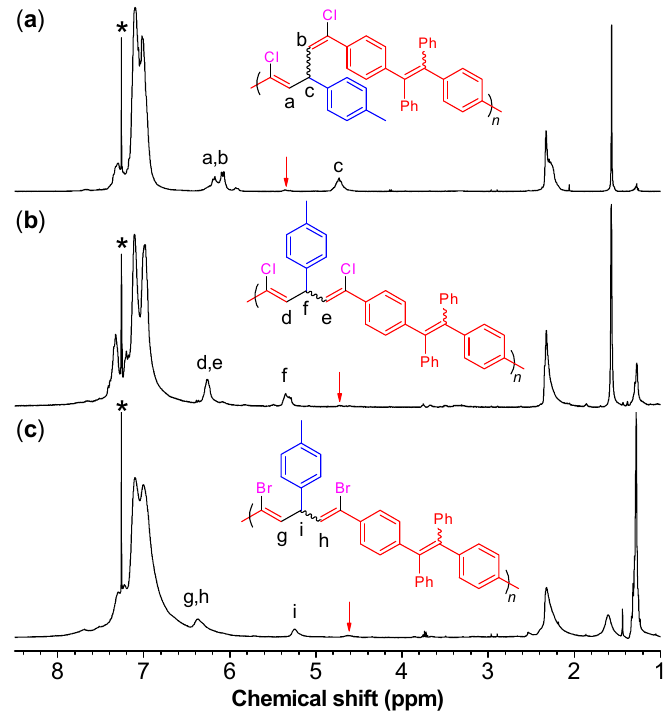
Figure 1. 1 H NMR spectra of ( a ) P 1 / 2 ; ( b ) P 1 / 2 -I (Table 1, no. 2) and ( c ) P 1 / 2 -II (Table 2, no. 3) in chloroform- d . The peaks related to chloroform- d are marked with